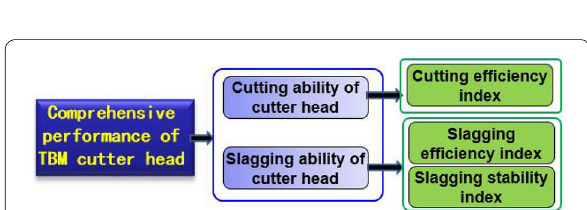
Figure 2 Performance evaluation system of the TBM